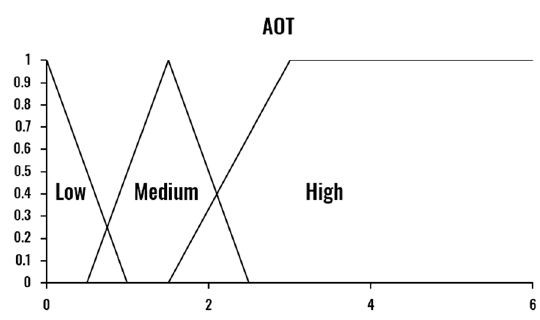
Figure 5. Fuzzy membership functions for average mouth opening time (AOT).